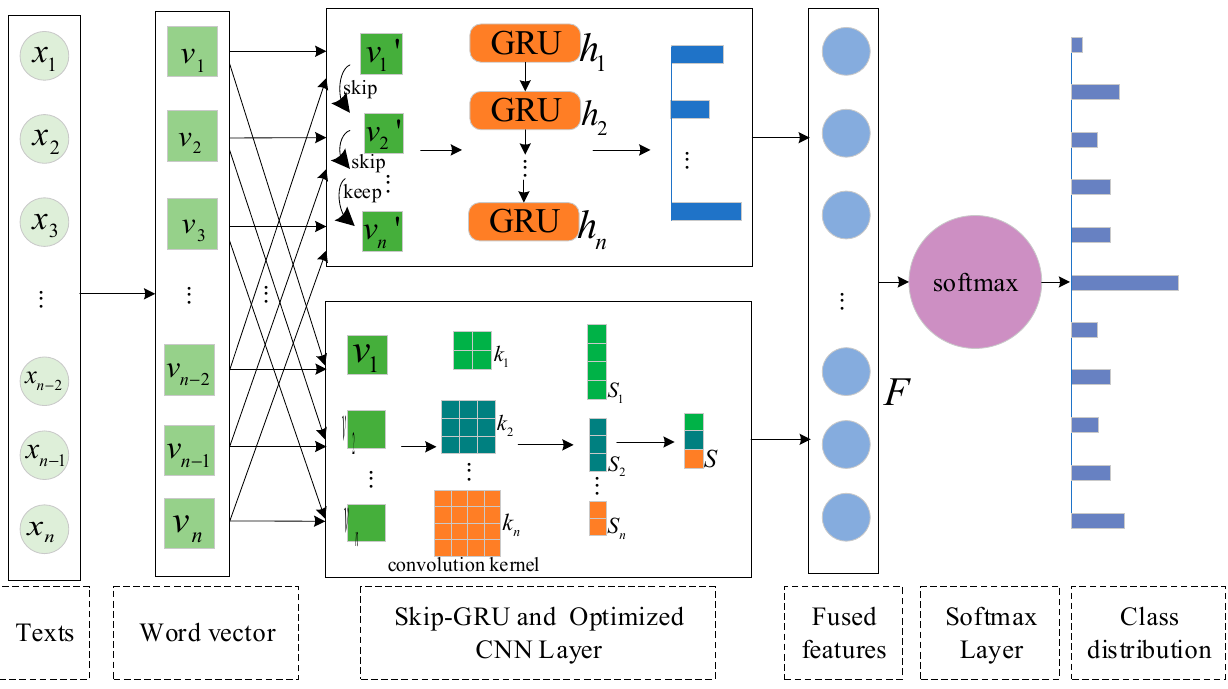
Figure 1. Overall structure of SA-SGRU.